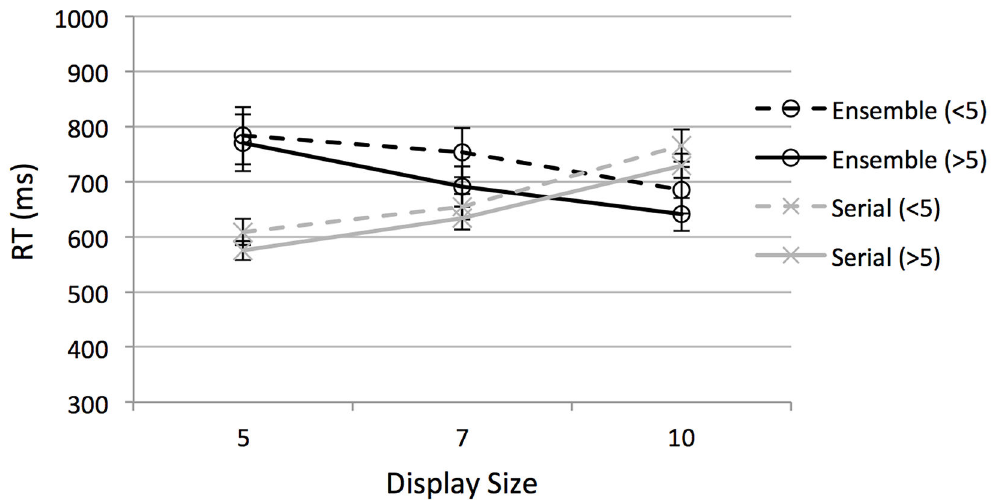
Figure 7. RTs for the serial search (gray) and ensemble (black) tasks in Experiment 2 plotted as a function of display size and separated by target type. Note. Dashed lines indicate < 5 and solid lines indicate > 5. Error bars represent standard error of the mean. For serial search, RTs significantly increased with increasing display size, whereas for the ensemble task, RTs significantly decreased with increasing display size.